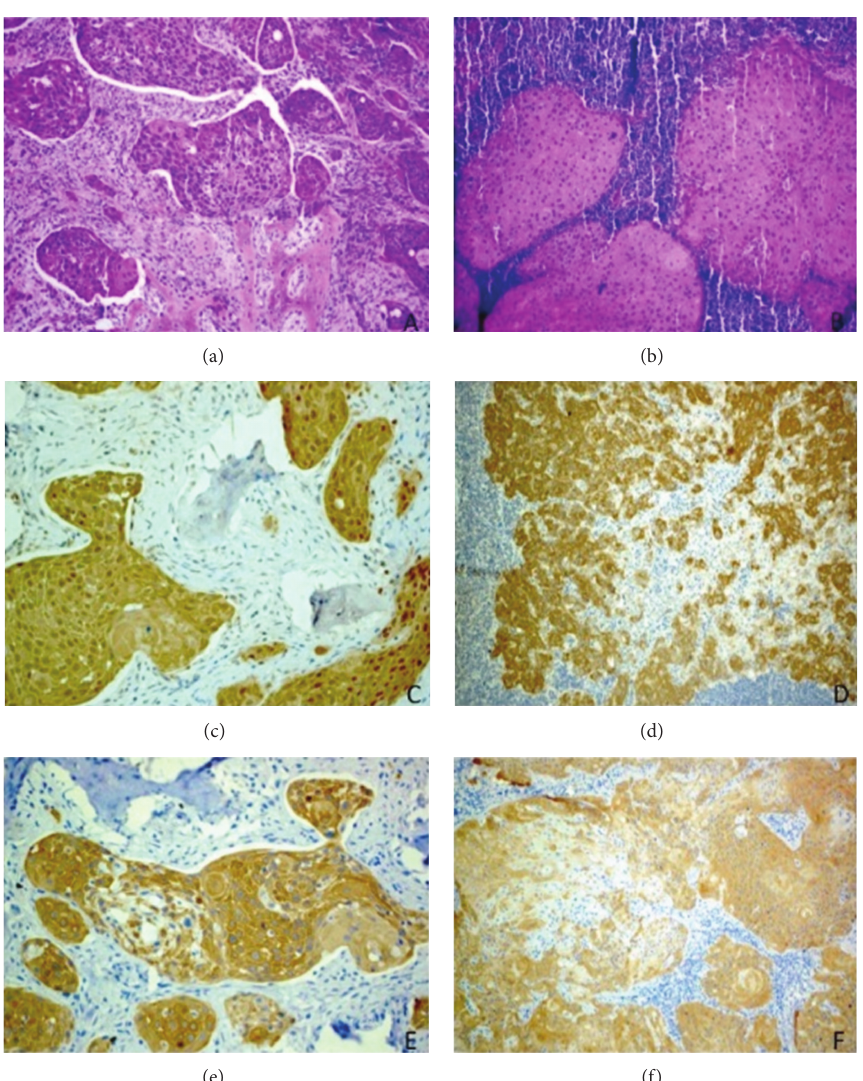
Figure 3: (a) Squamous cell carcinoma islands infiltrating the bone trabeculae. (b) Regional metastasis (HE 200x). (c) CK 5 immunohis- tochemical expression in the primary tumor. (d) CK 5 in regional metastasis. (e) CK 14 expression in the primary tumor. (f) CK 14 in the regional